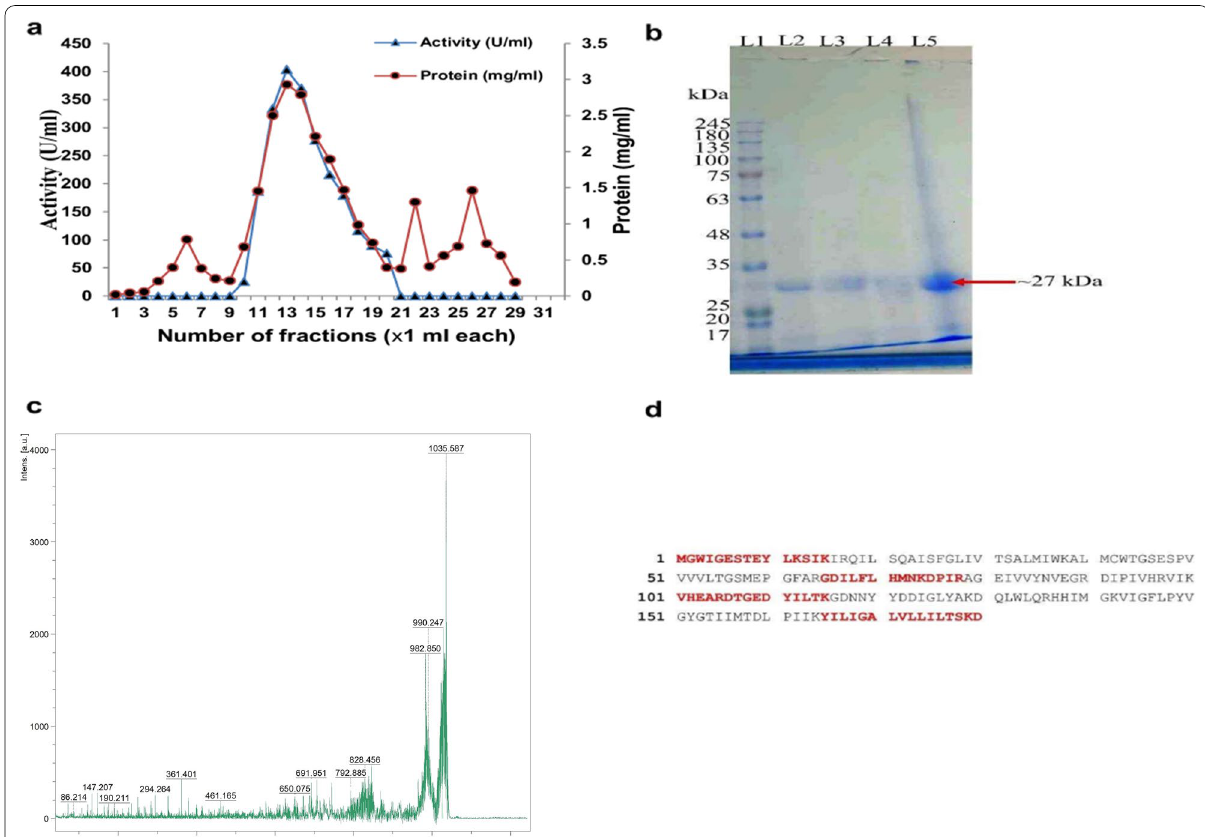
Fig. 1 a Protein concentration and activity profile of actinidin fractions from DEAE Sepharose column. The activity of 0.2 M NaCl gradient elutriated under standard assay conditions. b SDS-PAGE [Lane 1: HiMedia Molecular weight markers, Lane 2–4 (Fraction 12 to 14) and Lane 5 (pooled fractions): purified actinidin sample]. c Peptide mass spectra of gel spots. d MASCOT search engine results using peptide mass fingerprinting